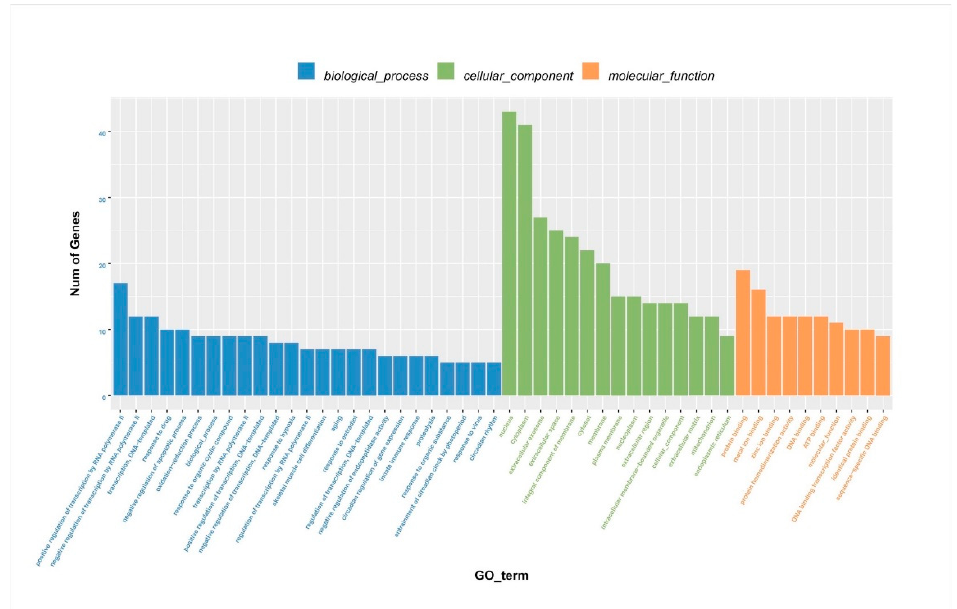
Figure 4. Column chart of DEG GO enrichment analysis. DEGs: differentially expressed genes; GO: gene ontology.